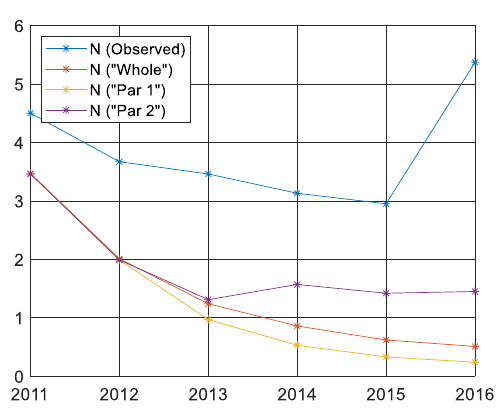
Fig. 5. Comparison between model results and observed concentrations, yearly averaged values (total nitrogen).